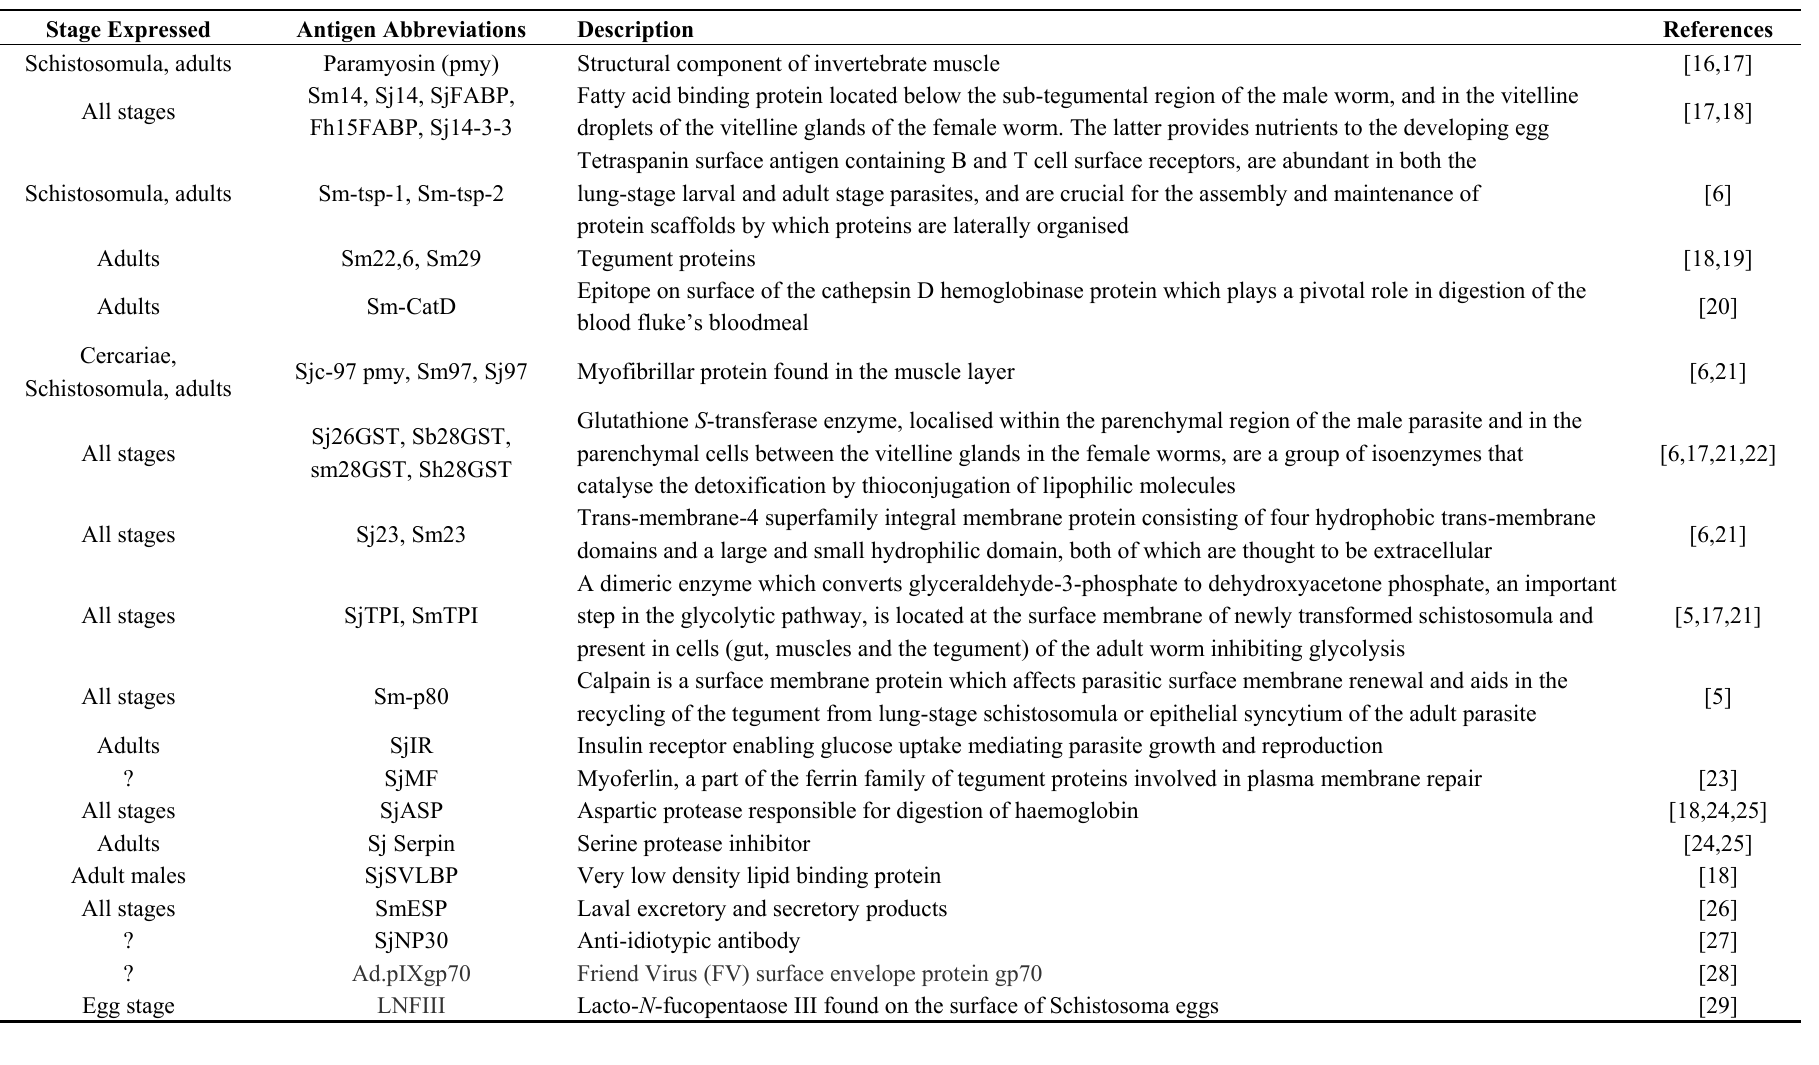
Table 2. Description of some Schistosoma antigen